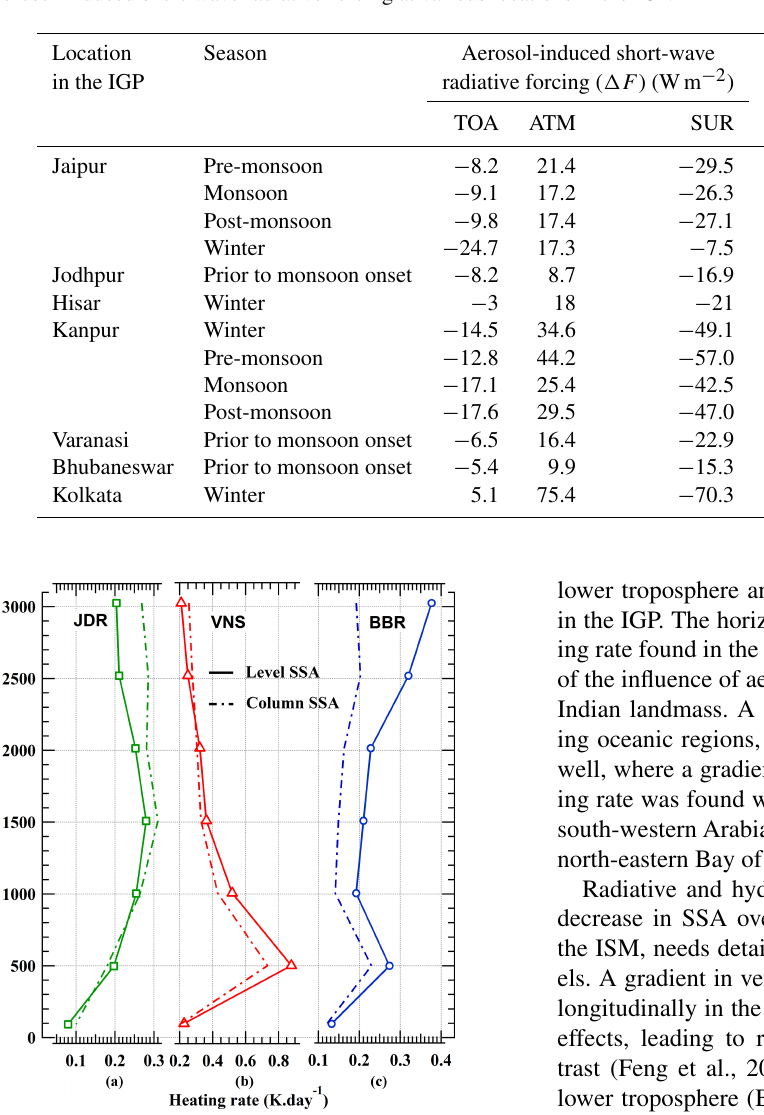
Figure 9. Altitudinal heating rate profiles for the stations (a) JDR, (b) VNS and (c) BBR. Solid lines are for heating profiles calculated using in situ aircraft profile data and layer-averaged aerosol proper- ties. Dashed-dotted lines represent heating profiles calculated using in situ aircraft profile data and column-averaged aerosol